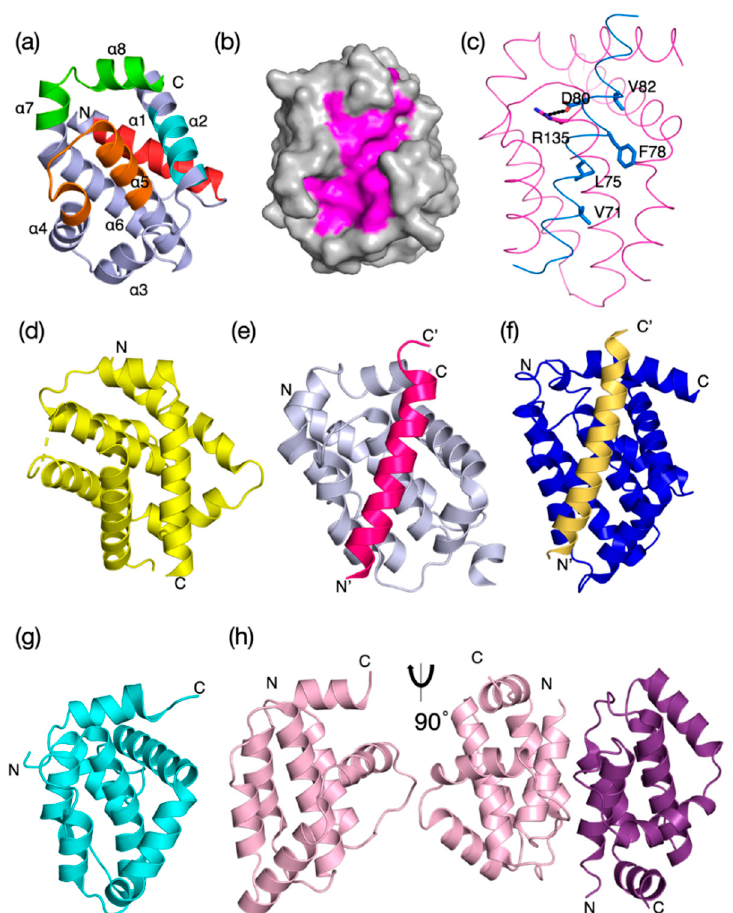
Figure 3. Evolutionary structure conservation in the Bcl-2 family and their complexes. Ribbon representation of the 3D structures of prosurvival and proapoptotic Bcl-2 family members and their complexes are shown. The helical bundle Bcl-2 structure occurred early in evolution and changed little over evolutionary time scales. ( a ) H. sapiens Bcl-x L (PDB 1R2D) with BH1–4 motifs colored in orange, green, cyan, and red as shown in the sequence–structure alignment of Figure 2a, ( b ) H. sapiens Bcl–x L (PDB 1R2D) shown as grey surface with canonical ligand-binding groove shaded in magenta, ( c ) BHP2 from the sponge G. cydonium Bcl-2, BHP2 (PDB 5TWA) magenta, LB–Bak sky blue. The canonical ionic interaction between the conserved Arg from prosurvival Bcl-2 and conserved Asp from the BH3 motif of prodeath Bcl-2 as well as the four conserved hydrophobic residues from the Bak BH3 motif are shown as sticks. ( d ) M. musculus Bax (PDB 5W62) yellow, ( e ) H. sapiens Bcl-b:Bim complex (PDB 4B4S), ( f ) C. elegans CED-9: EGL-1 complex, CED-9 (navy) with EGL–1 (sand) in the binding